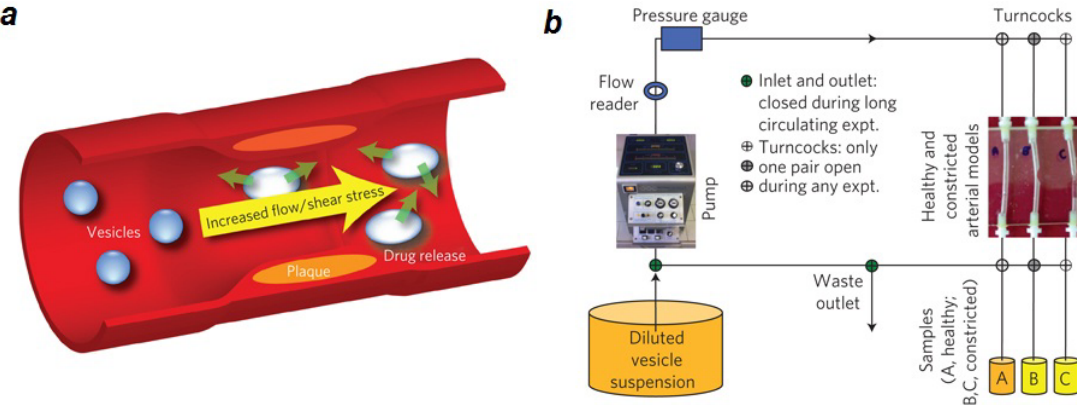
Figure 2. Shear-stress sensitive nano-sized lipid vesicles for targeted drug delivery. ( a ) Schematic of the design, in which changes in endogenous shear stress trigger